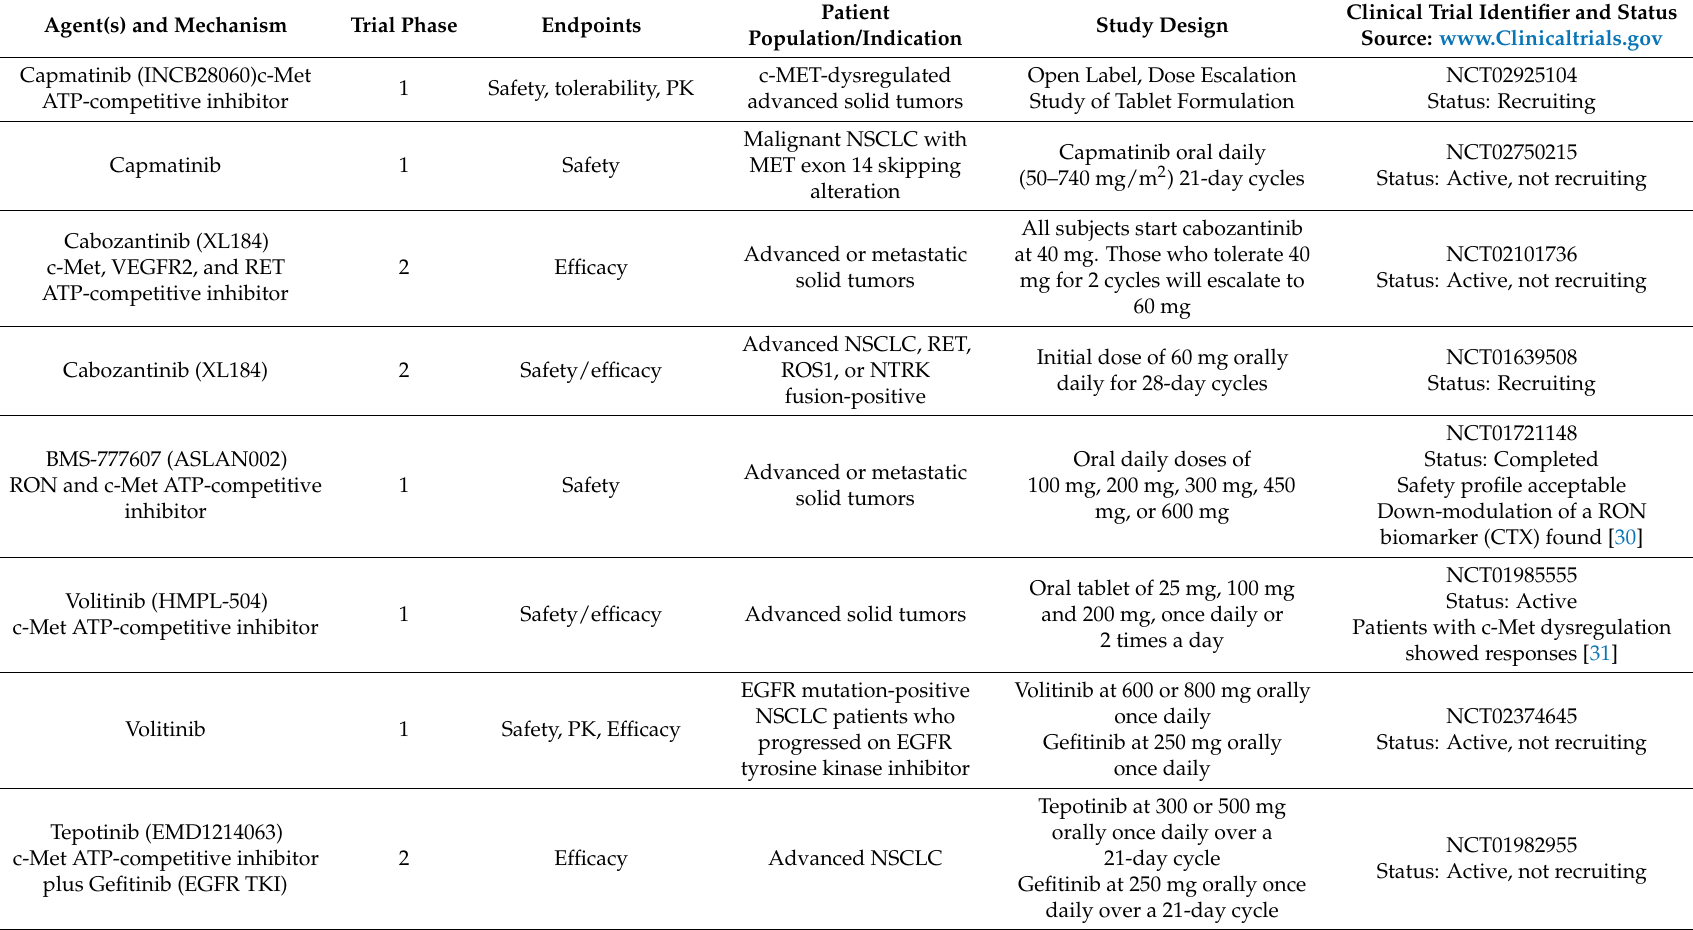
Table 1. Active or Recent Clinical Trials of hepatocyte growth factor (HGF)-MET Inhibitors in Lung Cancer or in Solid